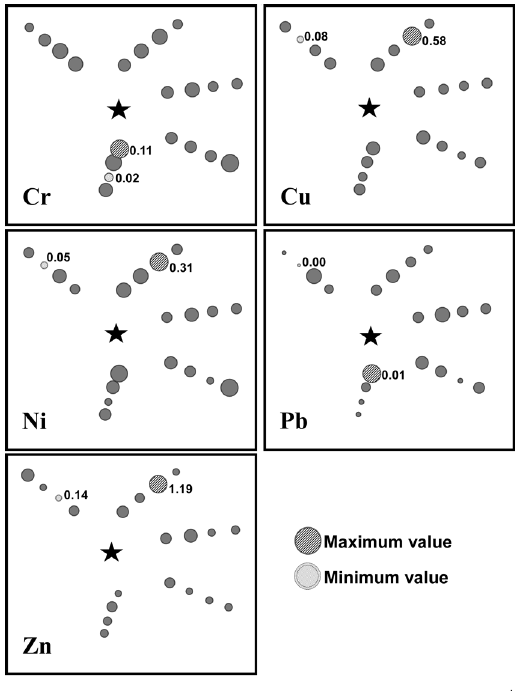
Figure 3: Biological concentration factor of heavy metals in Z. coccineum grown around the cement factory. The minimum and maximum values are written near to the corresponding